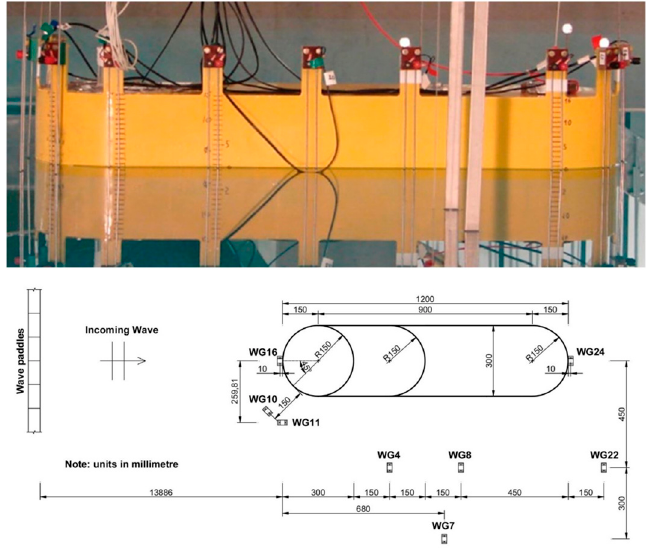
Figure 7. Layout of the test FPSO [22].